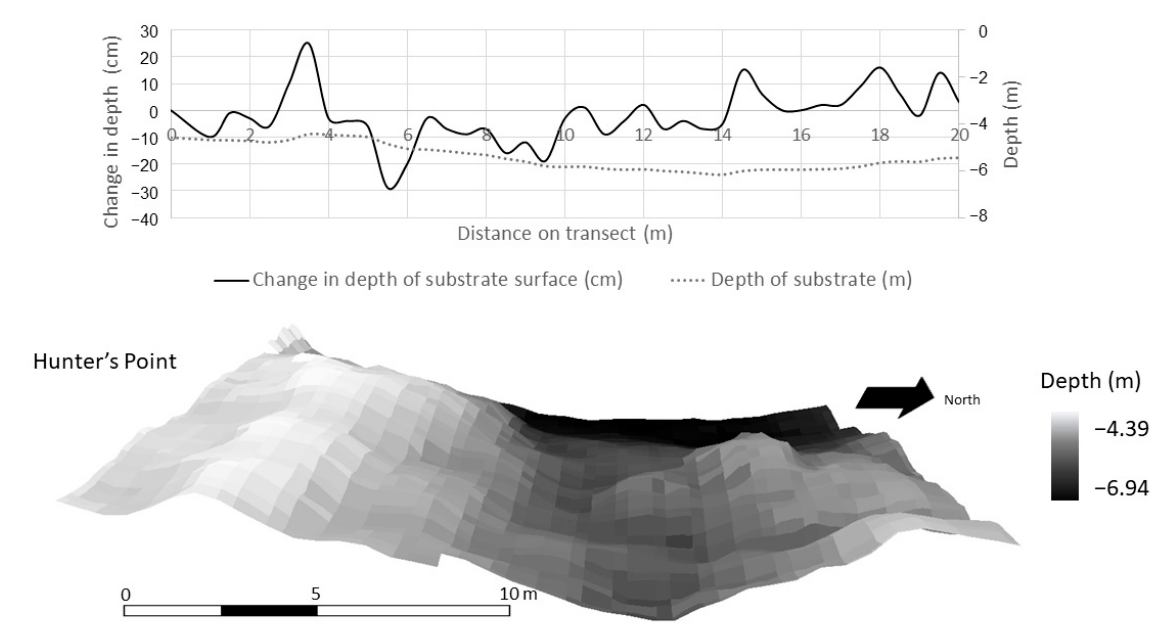
Figure 10. High resolution bathymetry (0.3 m) collected by an autonomous underwater vehicle in Lake Superior in a randomly selected 20 m × 20 m plot at Hunter’s Point. Depth profile ( top ) and area ( bottom ) documenting microtopography of periphyton habitat.